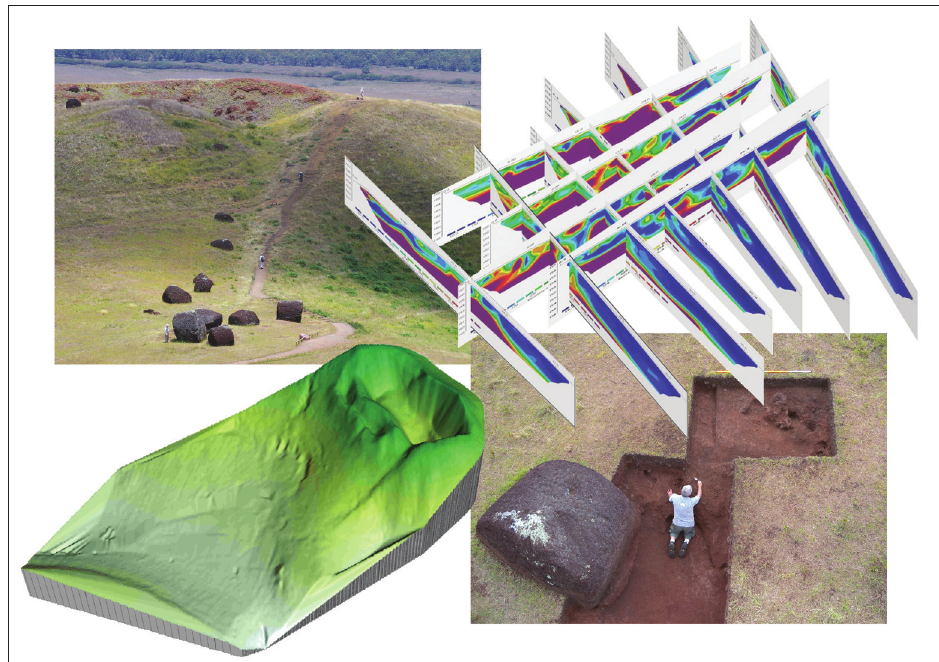
Fig. 4: Fieldwork at Puna Pau. Clockwise from top left: exterior of the Puna Pau crater, with the line of pukao marking the main route out of the quarry (photo: M. Seager Thomas); tomography analysis of the exterior of Puna Pau (image: S. Ovenden); excavation of a pukao and associated ‘road surface’ on the exterior of Puna Pau (photo: A. Stanford); and laser scanned topography of Puna Pau (image: K.